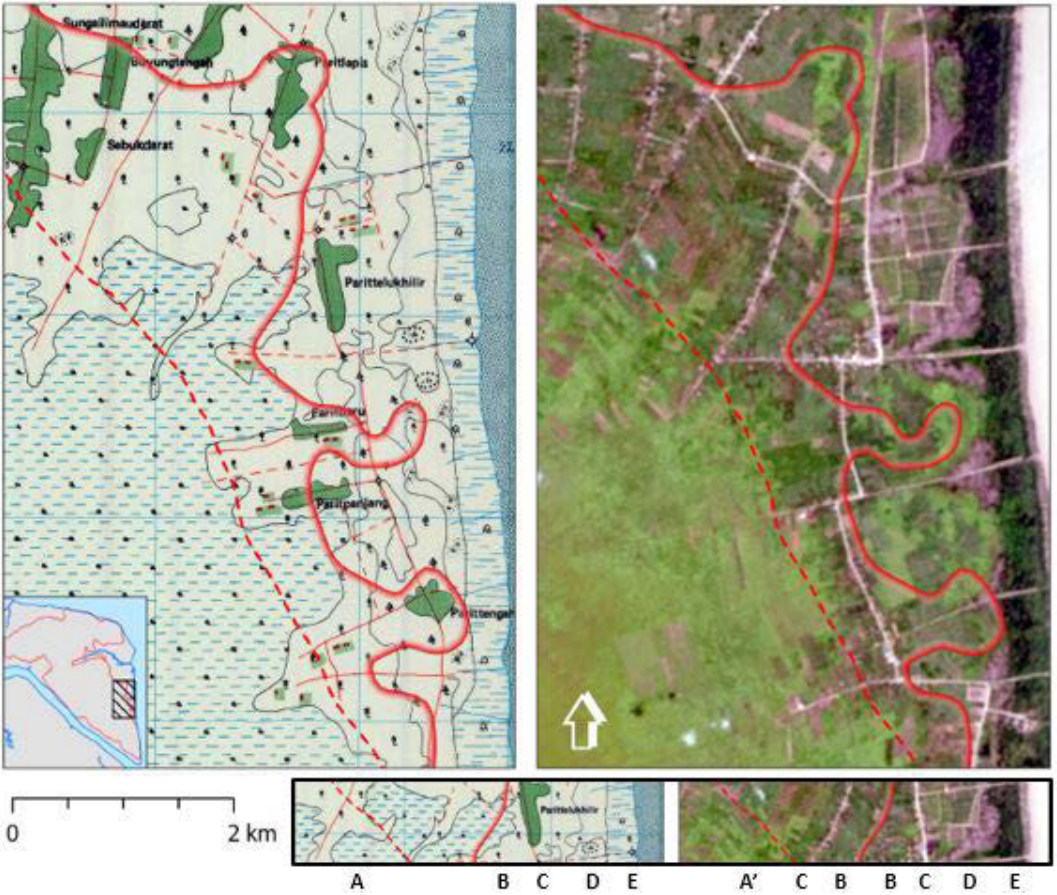
Figure 7. Comparison of the 0.40 m isopach (solid red line, perimeter of shallow peat) and the 3.0 m isopach (dashed red line, perimeter of deep peat) from this study with peat swamp (A), oil palm plantation (A’), mixed crops (B), settlements and roads (C), bare land (D) and mangroves (E) from the 1:50,000 scale topographic map (BIG 2018) (left) and Landsat 8 OLI 15 m multi-temporal Pansharpened Natural Color image (ESRI 2019)